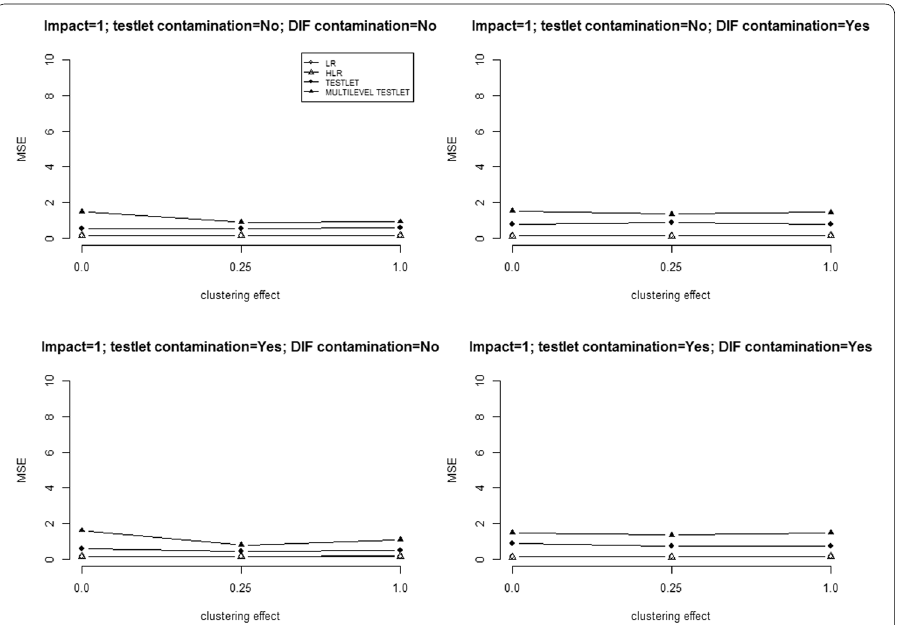
Fig. 8 Effects of testlet contamination and DIF contamination at each level of person clustering effect when there is impact between